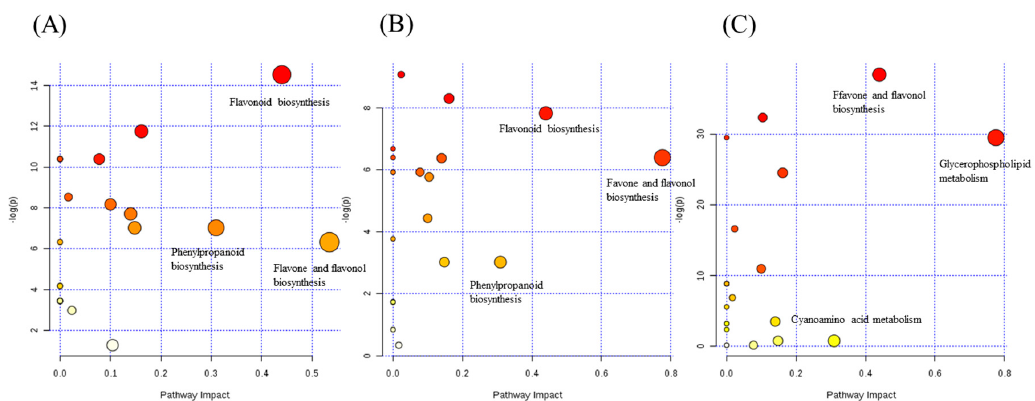
Figure 6. Pathway analysis of the identified metabolites. Each point represents one metabolic pathway; the size of the dot and shades of color represent a positive correlation with the impaction of the metabolic pathway. ( A ) The pathway analysis of the identified metabolites of the QP/CP group; ( B ) the pathway analysis of the identified metabolites of the ZS/ZQ group; ( C ) the pathway analysis of the identified metabolites of the CR/CA group.